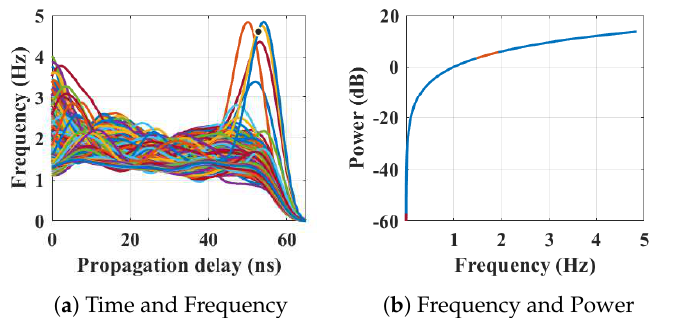
Figure 9. The relationship between propagation delay, activity frequency, and received power from the radar responses obtained while the person is watching television in the living room has been considered as C6 in classification phase.